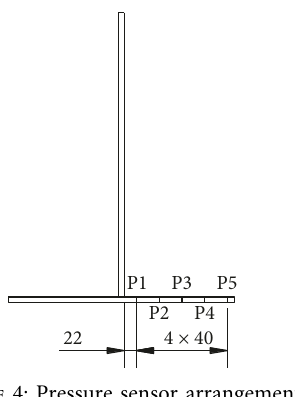
Figure 3: Model photo.